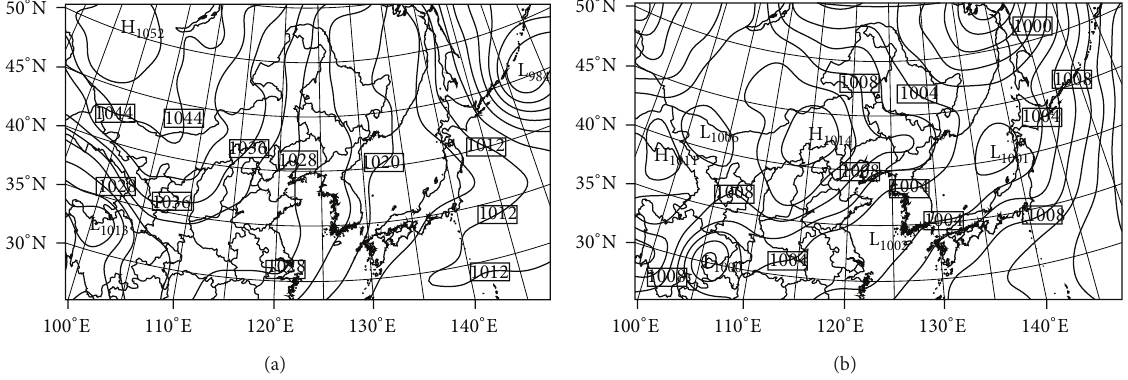
Figure 3: The observed sea level pressure field at (a) 0800 LST 16th of February 2012 and (b) 0800 LST 13th of August